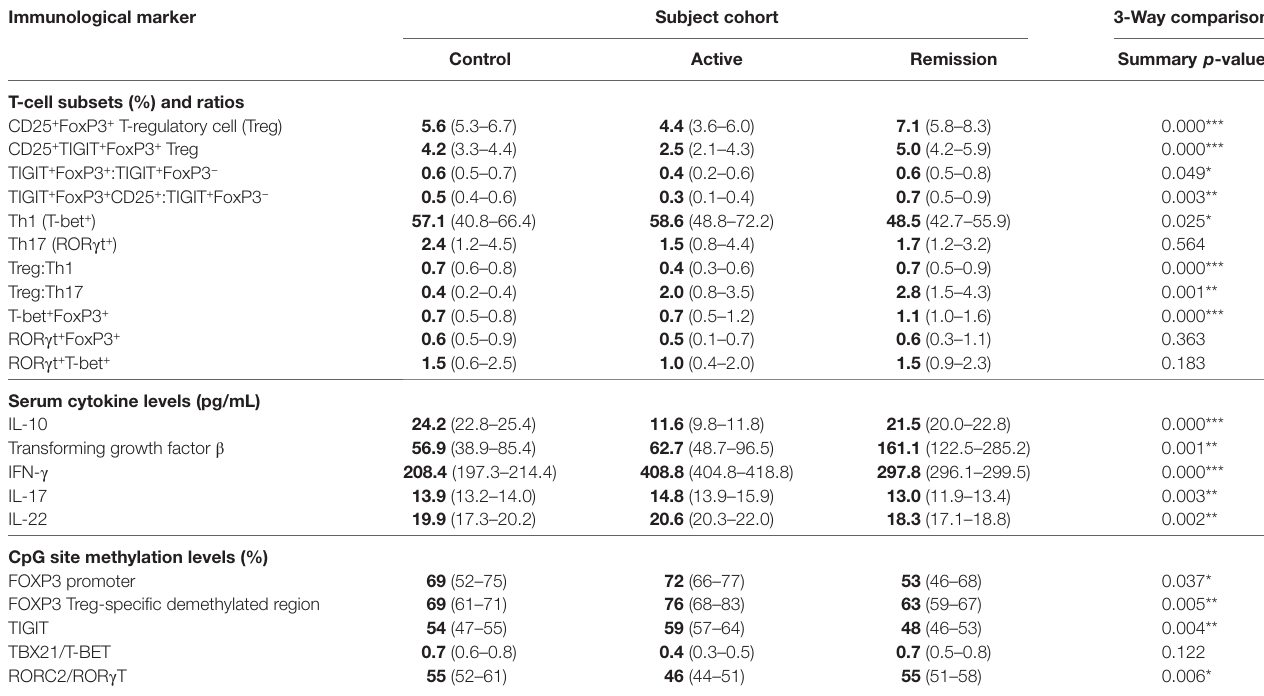
TaBle 3 | Comparison of immunological markers across the three subject groups. immunological